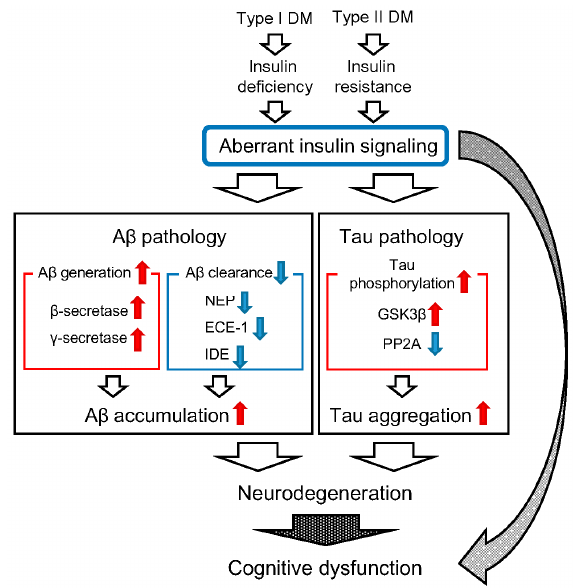
Figure 1. Hypothetical model illustrating the idea that diabetes mellitus induces Alzheimer’s disease (AD) pathology and cognitive dysfunction. Both type I and type II diabetes mellitus (DM) eventually cause aberrant insulin signaling. Histopathological evidence in animal model studies suggest that DM aggravates both β -amyloid protein (A β ) and tau pathology via aberrant insulin signaling, leading to neurodegeneration. Several studies show that aberrant insulin signaling also causes cognitive dysfunction by itself. That may be why DM patients exhibit greater susceptibility toward developing AD. Modification of the insulin signaling pathway may be a promising therapeutic target for preventing cognitive dysfunction in DM and AD patients. Red arrow, increase or upregulation; blue arrow, decrease or downregulation.